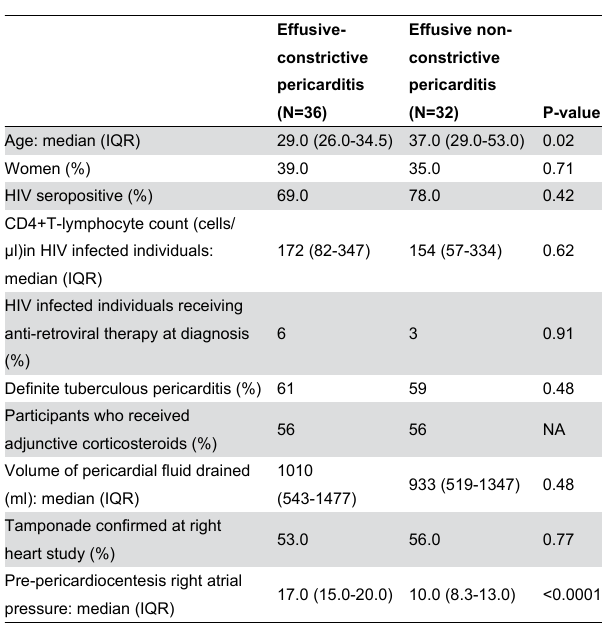
Table 1. Comparison of clinical and hemodynamic characteristics of patients with tuberculous effusive- constrictive pericarditis and effusive non-constrictive pericarditis at the time of enrolment into the